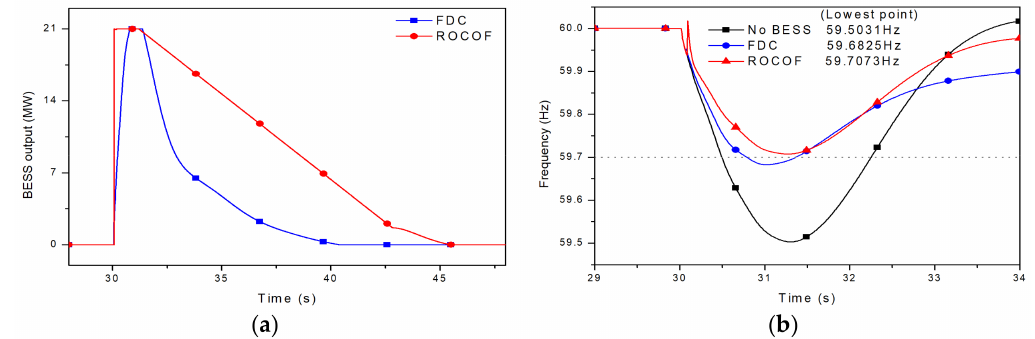
Figure 8. Power system frequency according to BESS output control when wind turbine is lost: ( a ) BESS output; ( b ) Frequency of the power